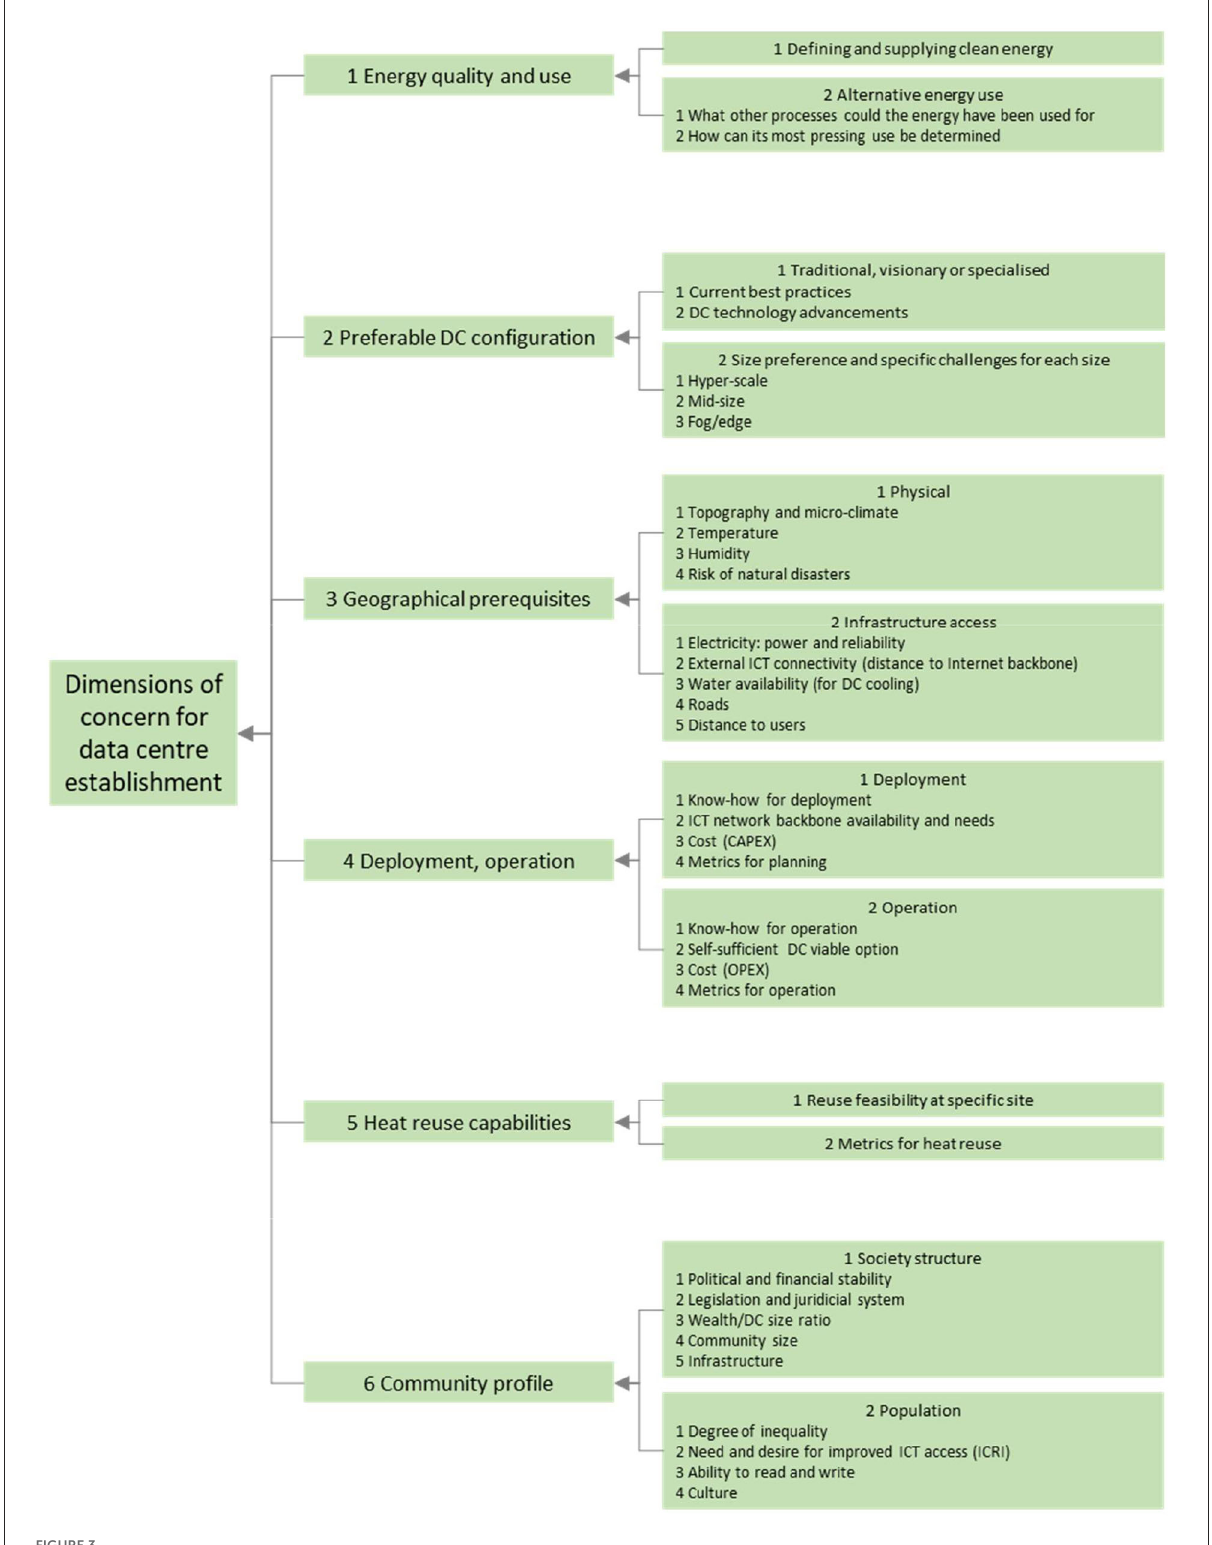
FIGURE3 Analytical framework and proposed checklist. DC, data